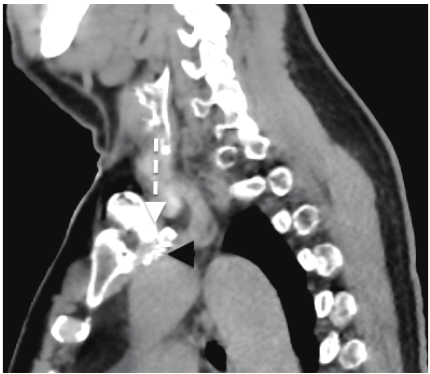
Figure 3: Sagittal view of left subclavian stent